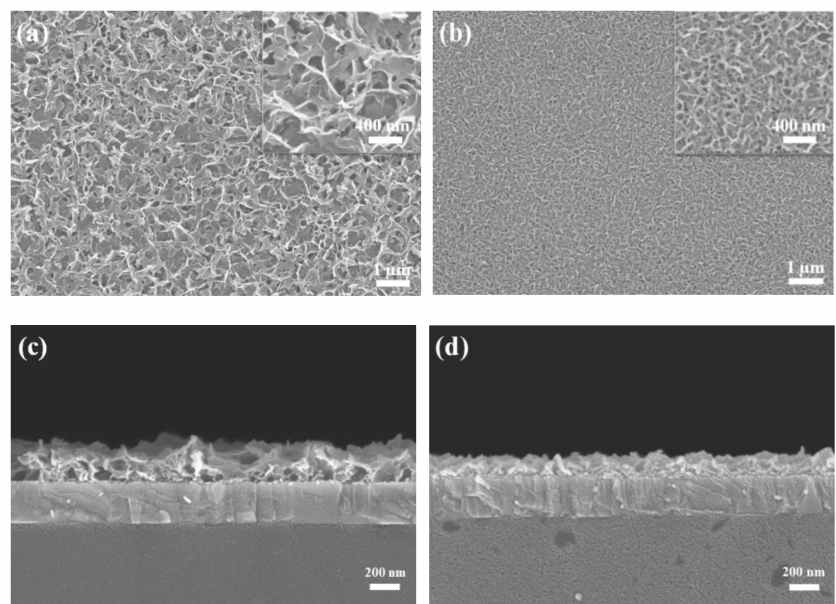
Figure 2. Top-view and cross-sectional SEM images of the ( a , c ) undoped and ( b , d ) Ni-doped ZnO NWLs.